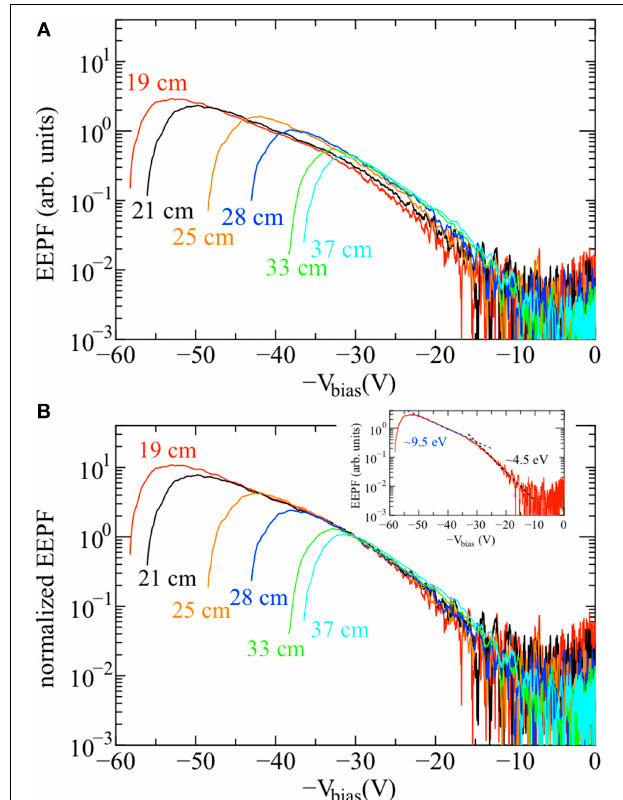
FIGURE 3 | (A) As measured EEPFs and (B) EEPFs normalized at V bias = 30V for increasing axial positions (from z = 19–37cm); the inset on (B) is the EEPF measured at z = 19cm showing the two Maxwellian fits (dotted lines) for the trapped (9.5eV) and escaping (4.5eV) electrons; the break energy is defined as the intersection between the two